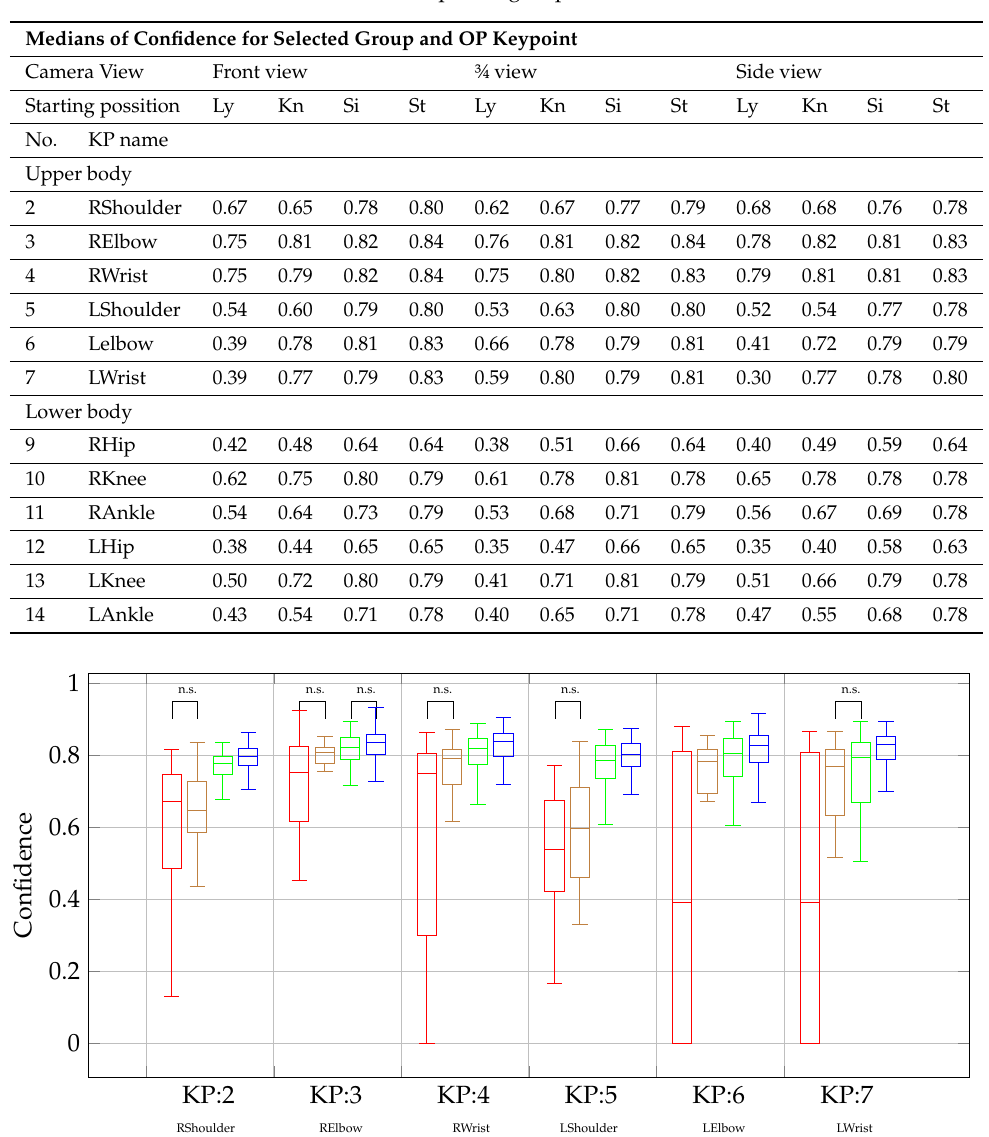
Table 4. Median confidence value for each specific group.